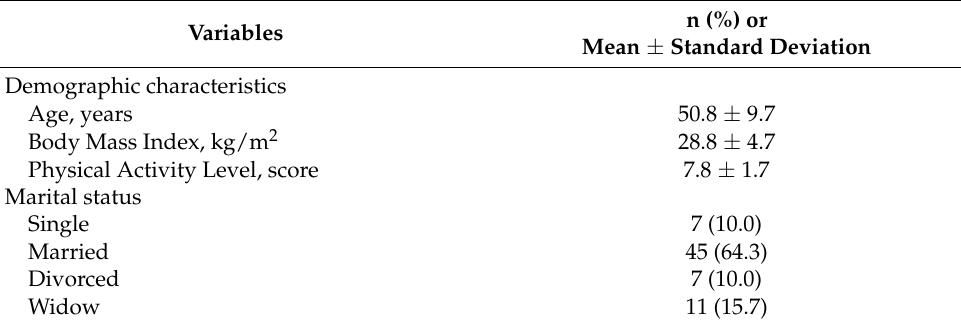
Table 1. Characteristics of the sample (n =